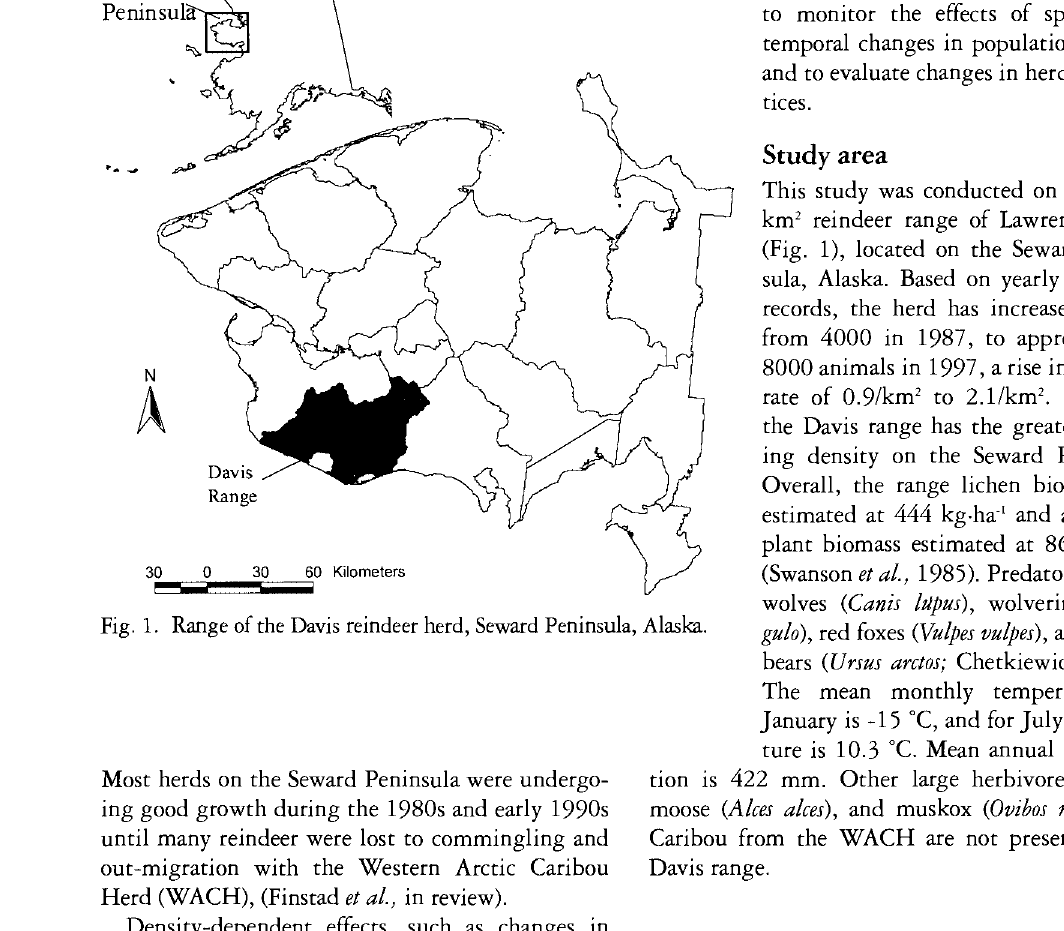
Fig. 1. Range of the Davis reindeer herd, Seward Peninsula, Alaska